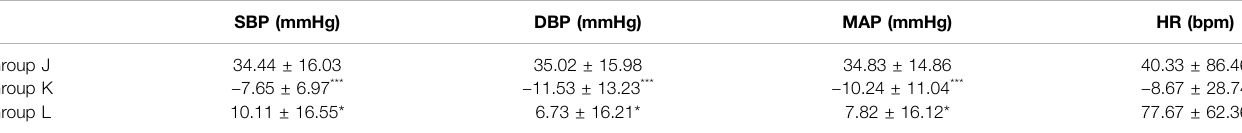
TABLE 2 | Variations in BP and HP after neostigmine treatment in rats.